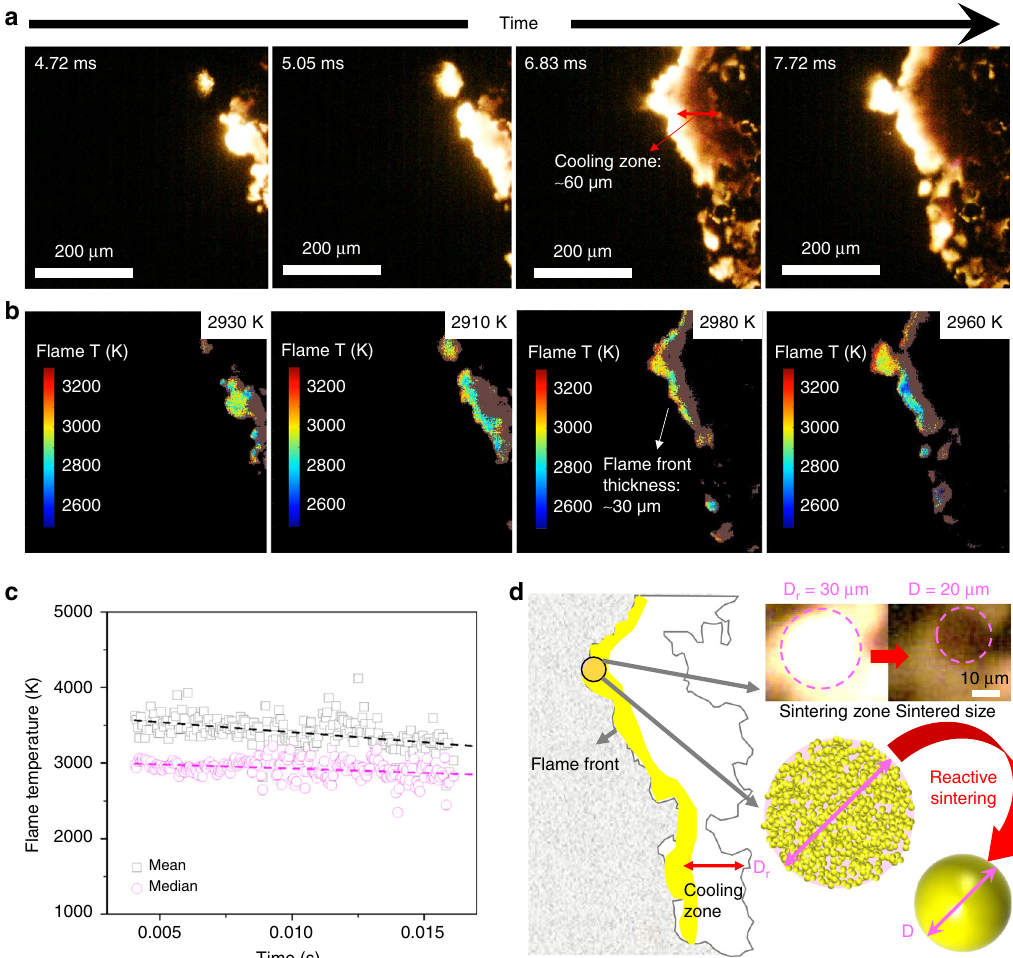
Fig. 2 Images and temperature maps from high-speed microscopy video. a Series of snapshots of burning fl ame front. Labeled on the left-top corner is the time after fl ame front entering the zone (512 µ m × 512 µ m). b The corresponding fl ame temperature maps and the average temperature (in Kelvin). High error points were marked as brown and are excluded from the calculations. c The mean (square marker) and median (round marker) fl ame temperature with time (with reference lines). d Schematic showing reactive sintering and its spatiotemporal relationship to reaction propagation. Note: The propagation direction is from right to